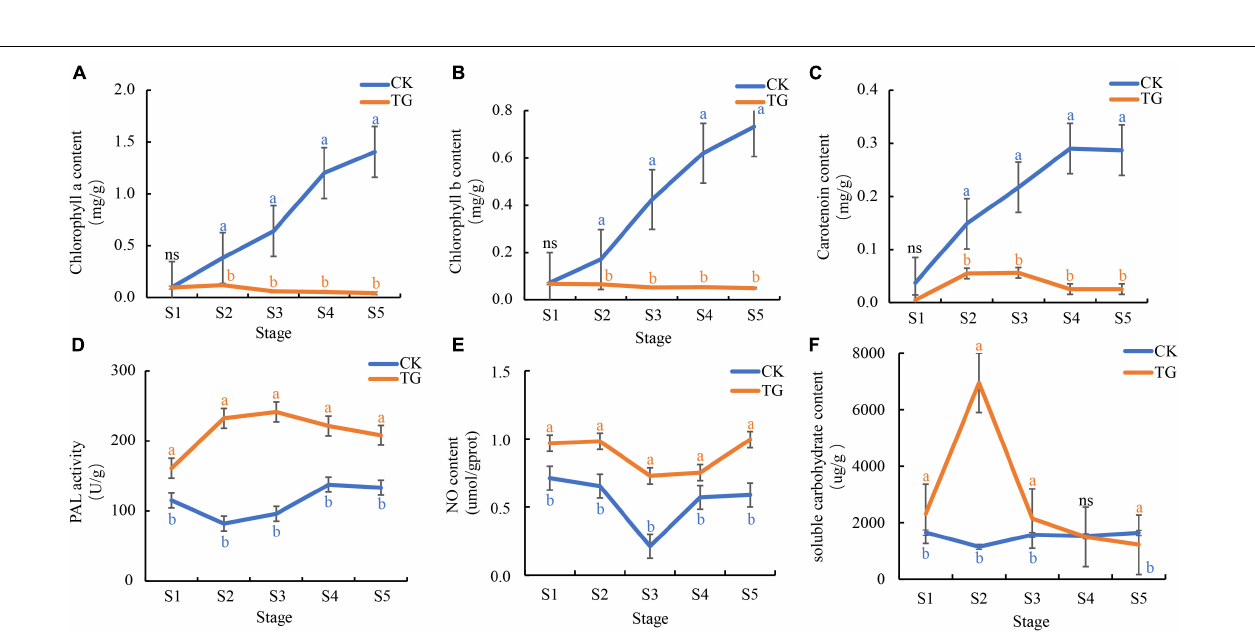
FIGURE 4 | Sclerospora graminicola inhibited the substance accumulation or enzyme activity related to photosynthesis. (A) Chlorophyll a content in CK and TG; (B) chlorophyll b content in CK and TG; (C) carotenoid content in CK and TG; (D) PAL activity in CK and TG; (E) NO content in CK and TG; (F) soluble carbohydrate content in CK and TG. The letters indicate correlation significance at 5% probability ( P < 0.05), the same below.